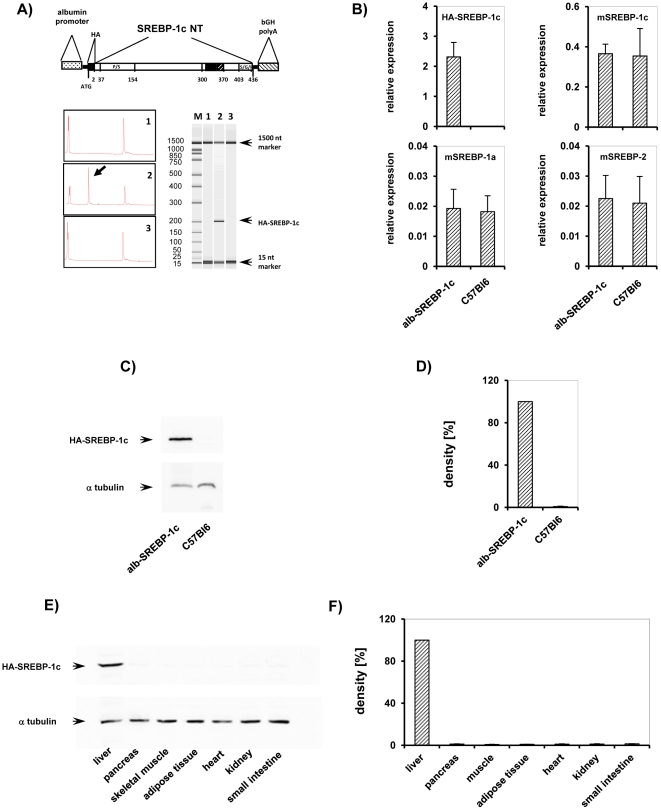
Tissue-specific over-expression of alb-SREBP-1c in vivo.(A) Scheme of the DNA constructs used to generate transgenic mice. The transcriptionally active N-terminal domain of the human SREBP-1c gene (aa 1–436 including a 5′-HA-tag (YPYDVPDYA) was inserted into a vector construct containing the mouse albumin promoter, a liver-specific enhancer element and a polyadenylation site. The SREBP-1c expression cassette was released by BssHI restriction for microinjection into male pronuclei of zygotes derived from C57Bl6 mice. (A) Verification of transgene insertion into genomic DNA was performed by PCR. M: size marker, genomic DNA of lane 1: C57Bl6, 2: alb-SREBP-1c, and lane 3: no template control. (B) Validation of transgene expression of alb-SREBP-1c animal model on mRNA level by RT-PCR. RNA extracted from snap-frozen liver biopsies from male alb-SREBP-1c and C57Bl6 mice was analyzed by RT-PCR with transgene human SREBP-1c (HA-SREBP-1c) , mouse SREBP-1a (m-SREBP-1a), mouse SREBP-1c (m-SREBP-1c) and mouse SREBP-2 (m-SREBP-2) specific primers and probe. The relative RNA amount shown in arbitrary units was calculated and plotted ± S.D. Graphs represent data from four male mice per genotype, each analyzed in triplicate (p<0.01). (C) Verification of transgene expression on protein level in liver. Protein extracts of snap-frozen liver biopsies from lane 1: alb-SREBP-1c, 2: C57Bl6 mice were separated by SDS-PAGE and blotted on nitrocellulose membrane. The membrane was probed with HA-specific antibody to determine the HA-tag of the transgene construct. A representative experiment is shown. For normalizing, blots were probed with α-tubulin antibody. (D) Graphs show densitometry evaluation of n = 5 independent experiments. (E) Tissue-specific expression of alb-SREBP-1c. Protein extracts of lane 1: liver, 2: pancreas, 3: skeletal muscle, 4: adipose tissue, 5: heart, 6: kidney and 7: small intestine were separated by SDS-PAGE, blotted and probed with HA-specific antibody. A representative experiment is shown. The arrow indicates HA-tagged SREBP-1c. For normalizing, blots were probed with α-tubulin antibody. (F) Graphs show densitometry evaluation of n = 5 independent experiments.